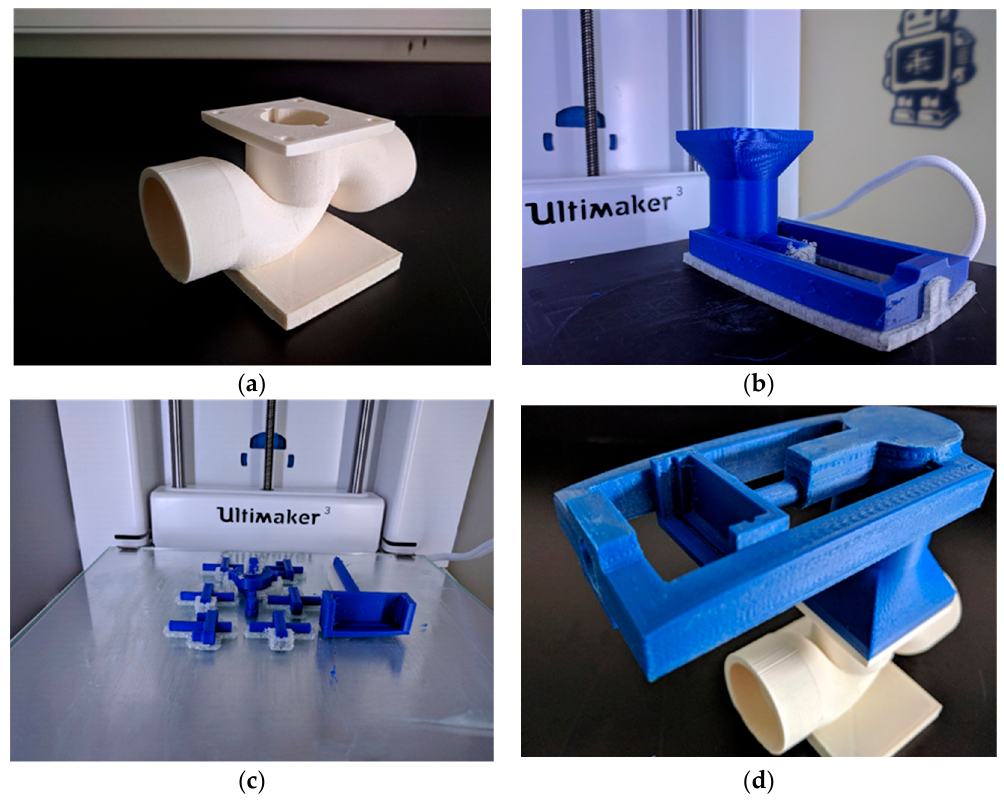
Figure 6. ( a ) Manufactured valve body. ( b ) Manufactured valve bonnet. ( c ) Manufactured mechanism components. ( d ) Assembled